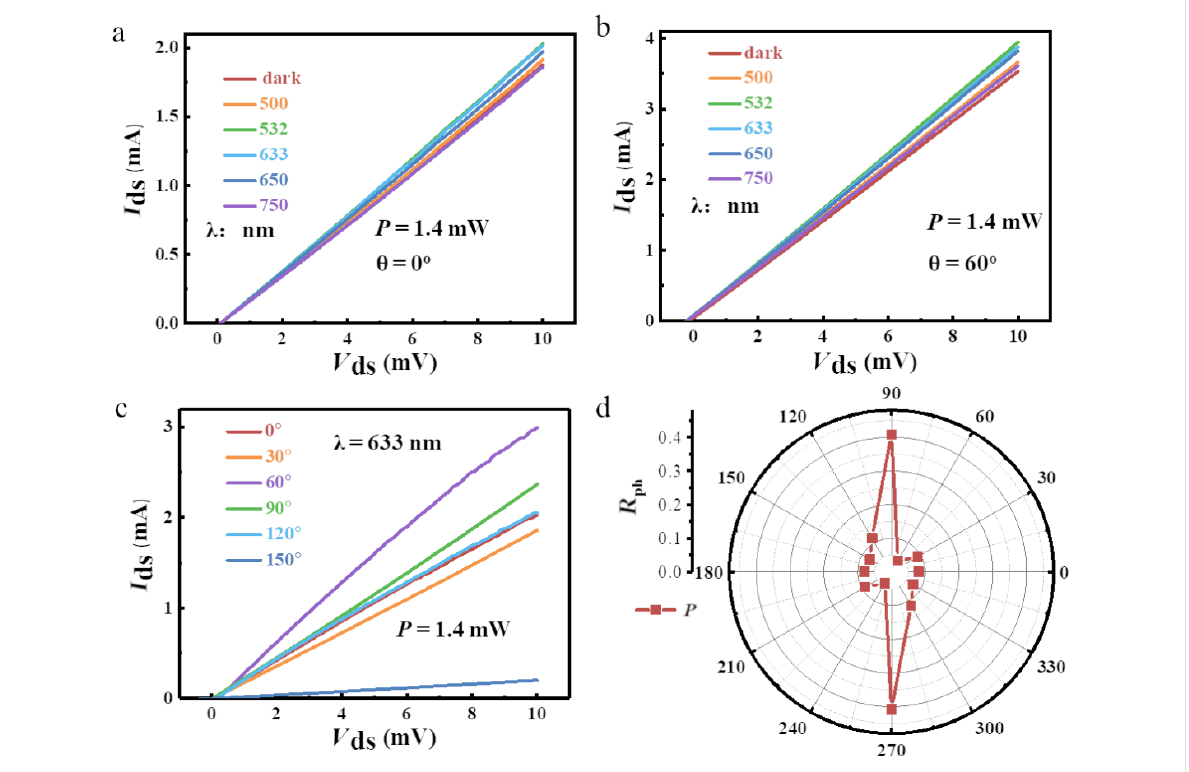
Figure 4: Wavelength- and angle-dependent photoelectric properties of 1T’-WTe 2 . a,b) The I–V curves of test angles at 0° and 60°, respectively, with incident wavelength varying from 500 to 750 nm. The incident power was set at 1.4 mW. c) I – V curves of different test angles (from 0° to 150°) with incident wavelength at 633 nm and power at 1.4 mW. d) Angle-resolved photosensitivity of 1T’-WTe 2 in polar coordinates (wavelength: 633